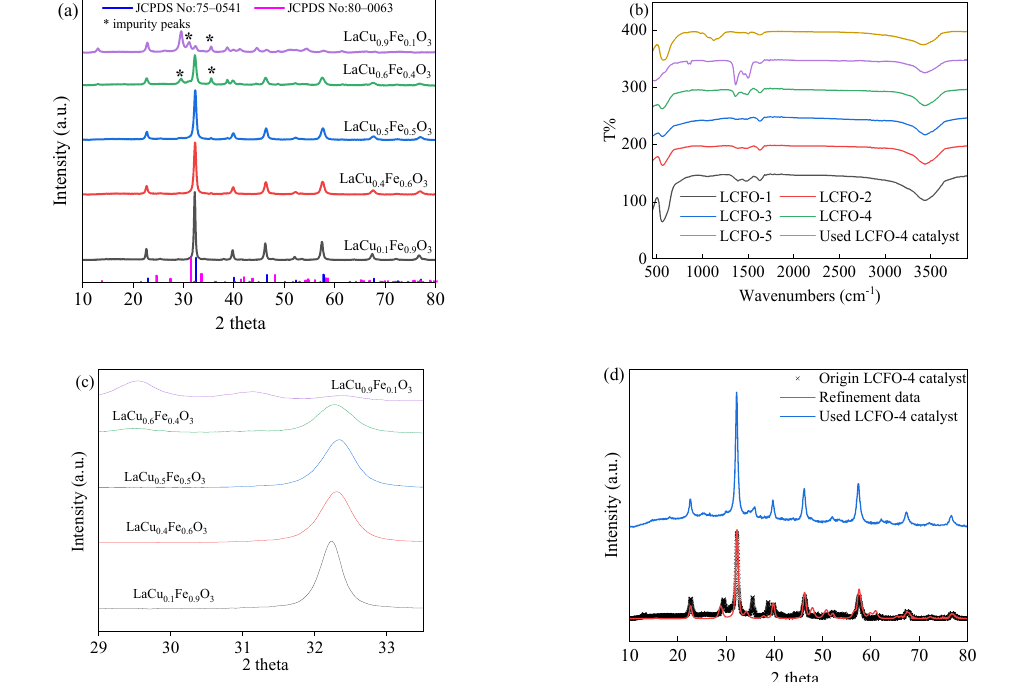
Figure 1. XRD patterns ( a ); and FTIR spectra ( b ) of LCFO catalyst, enlarged XRD patterns ( c ) and XRD patterns of refinement and used catalyst ( d